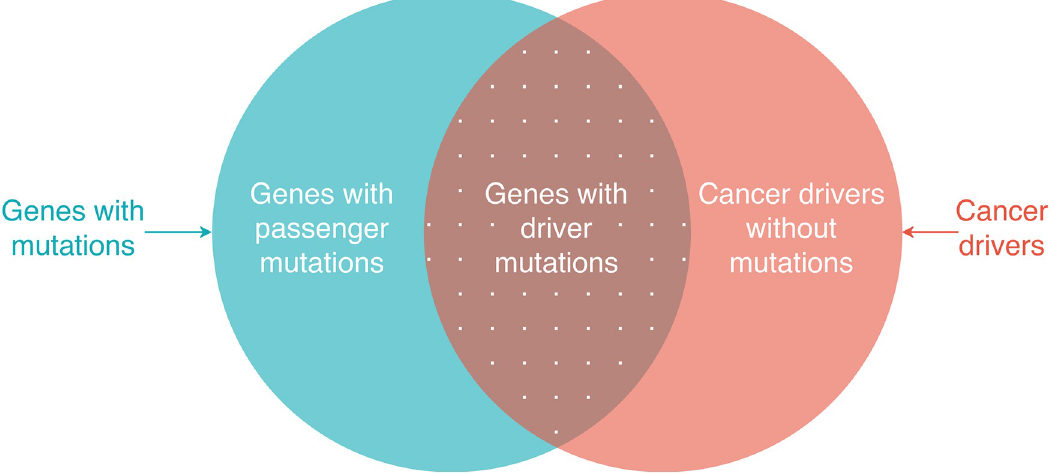
Fig 1. Coding cancer drivers and genes with mutations. Genes with driver mutations are cancer drivers. Some genes which do not bear mutations but regulate driver mutations to progress cancer are also considered as cancer